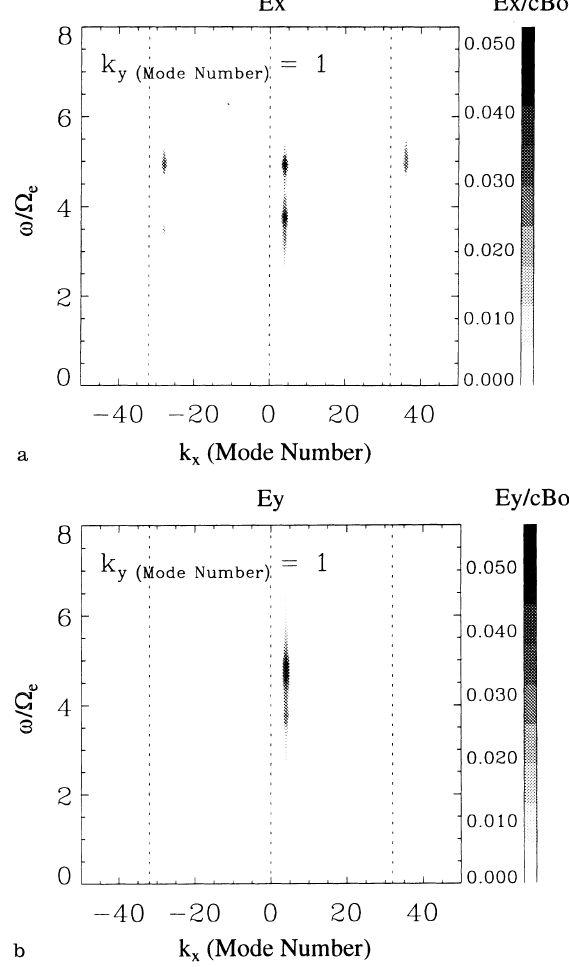
Fig. 7a,b. (cid:120) (cid:255) k x diagrams of a perpendicular electric field E x , b parallel electric field E y . The pump electromagnetic wave (cid:133) (cid:120) (cid:136) (cid:120) o ’ 4 : 8 (cid:88) e ; k x (cid:136) k o ? (cid:136) 4 (cid:134) , the Z-X mode wave (cid:133) (cid:120) ’ 3 : 8 (cid:88) e ; k x (cid:136) k o ? (cid:134)